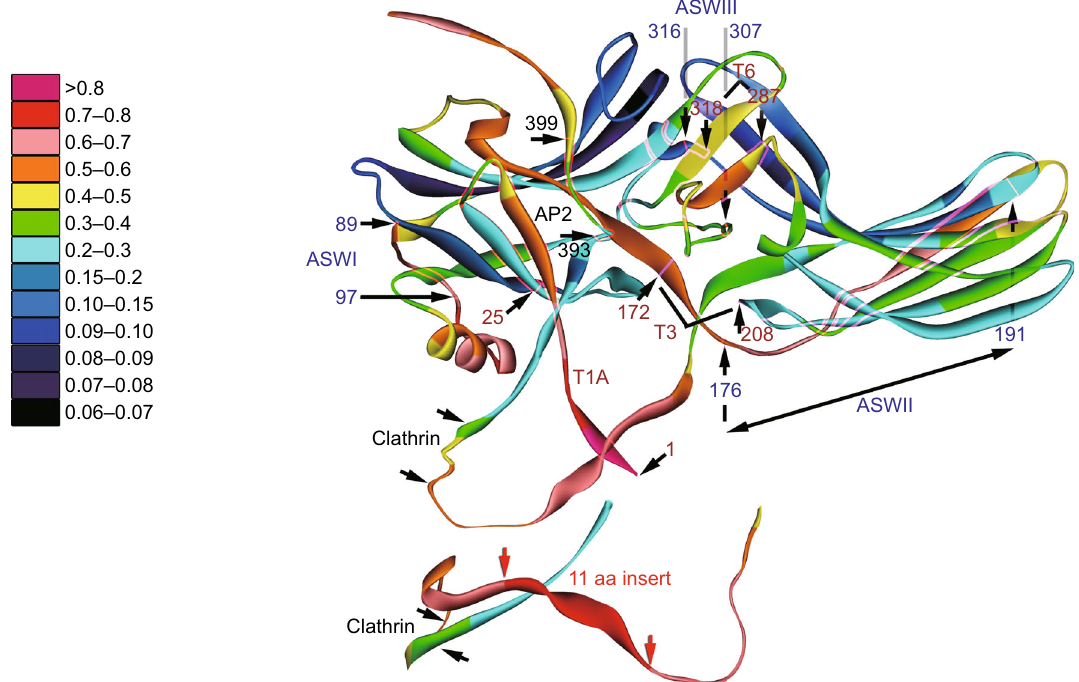
Figure 4. Functional implications of structural disorder. The structure of the basal state of arrestin-3 (PDB ID: 3P2D (Zhan et al., 2011)) is colored according to the propensity for structural disorder (color-code shown on the left). The C-terminus of the long splice variant of arrestin-3 with an 11-residue insert (as compared to the short splice variant (Sterne-Marr et al., 1993)) is shown below. Known functional elements are indicated on the structure: T1A peptide that facilitates the activation of JNK3 in cells (Zhan et al., 2016), residues 1 – 25; clathrin-binding element (residues 373 – 377 in the short splice variant), clathrin adaptor AP2 binding site (residues 393 – 399 in the short splice variant); JNK3-binding peptides T3 (residues 172 – 208) and T6 (residues 287 – 318) (Zhan et al., 2014); as well as arrestin switches that signi fi cantly change conformation upon activation (Chen et al., 2017): ASwI (residues 89 – 97), ASwII (residues 176 – 191), and ASwIII (residues 307 – 316). Note that JNK3-binding peptides T3 and T6 include ASwII and ASwIII, respectively. Also note that known functional elements are localized in regions of predicted high or moderate disorder. The